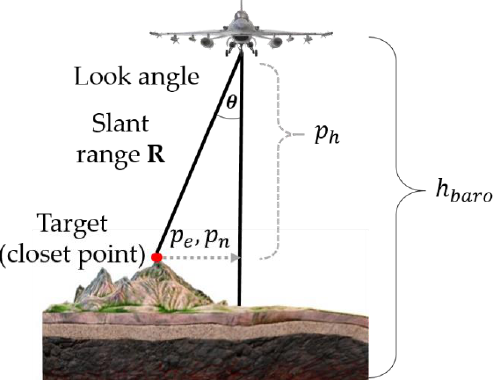
Figure 2. TRN measurement using IRA.